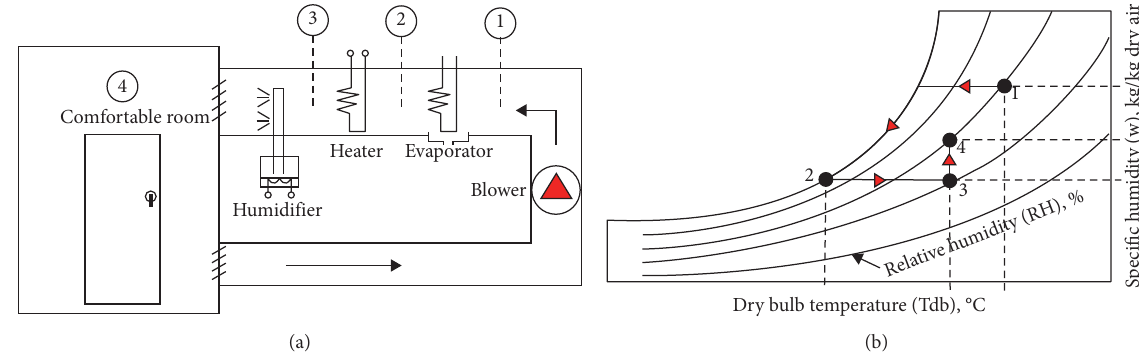
Figure 1: States of air properties in the comfortable room. (a) A/C system. (b) Psychometric chart.